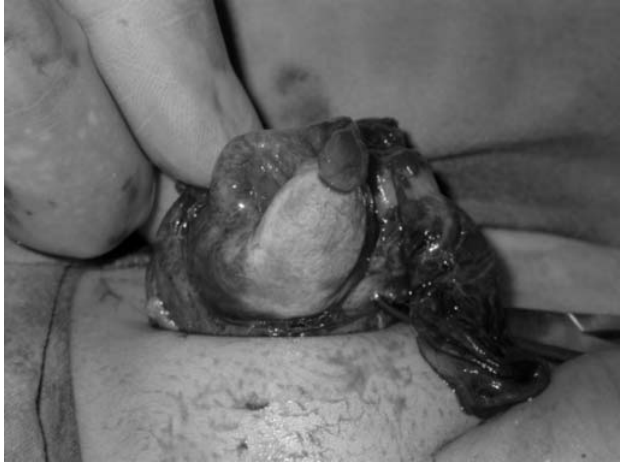
FIGURE 1. Intraoperative photograph during inguinal exploration with necrotic cyst. There was no membranous tissue representing the wall of hernia or hydrocele sac on the testis or testicular